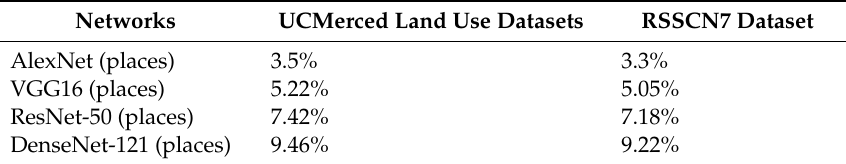
Table 7. The accuracy of fine classification with two public image